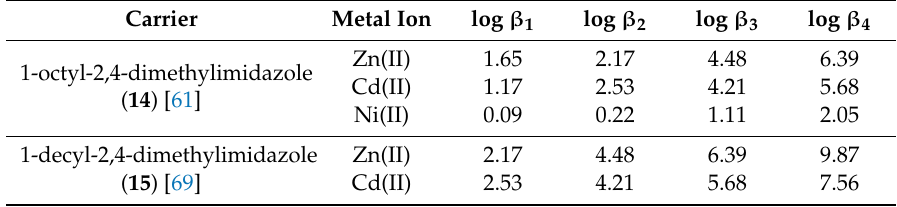
Table 5. The stability constants (log β n ) of Cd(II), Ni(II), and Zn(II) complexes with